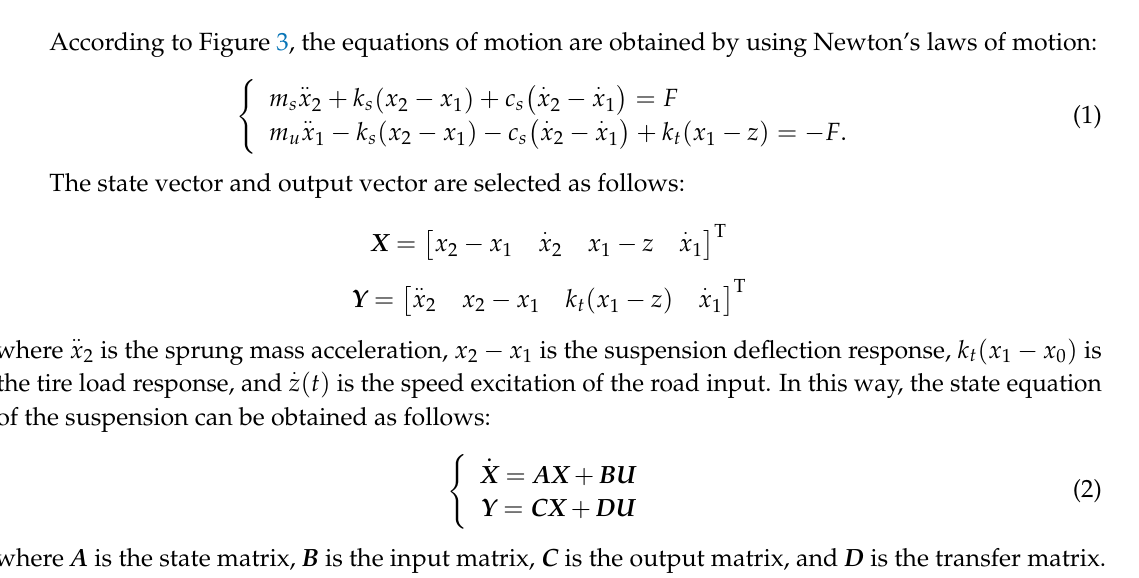
Figure 3. The schematic diagram of the quarter-car model.